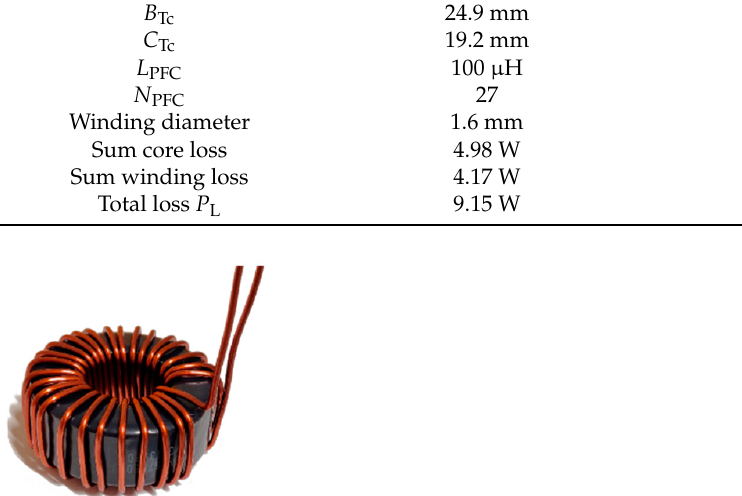
Figure 12. Assembled prototype of the toroidal PFC coil with N PFC = 27.